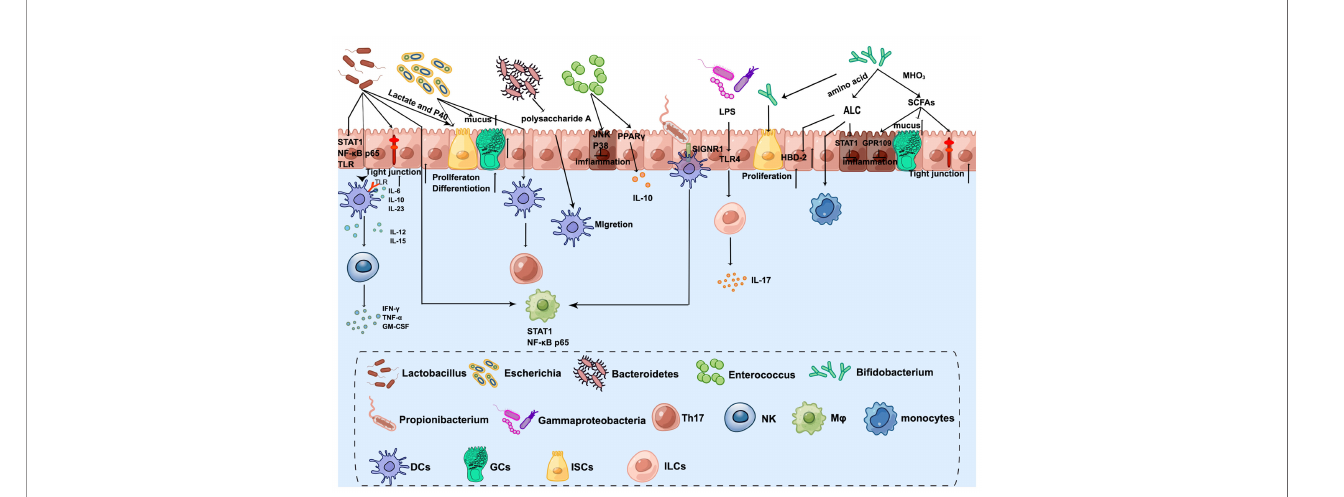
FIGURE 2 | The crosstalk between microbiota and innate immune system in the neonatal intestine. Lactobacillus enhances DC differentiation and upregulates surface markers, which activates NK cells. Furthermore, STAT1 and NF-kB p65 nuclear translocation are in fl uenced by Lactobacillus in both intestinal epithelial cells and underlying macrophages. Lactobacillus produced lactate and P40 can promote ISC-mediated epithelial development and tight junction formation. Bi fi dobacterium transfers amino acids into ALC, which activates monocytes and promotes the expression of beta-defensin2 of IECs. Additionally, ILA has anti-in fl ammatory effects on immature enterocytes through STAT1 pathways. Bi fi dobacterium releases SCFAs by metabolizing HMOs, which exert anti-in fl ammatory effects through GPR109A and increase tight junction and mucus gene expression. Furthermore, Bi fi dobacterium Tad pili stimulate the growth of the newborn mucosa. Escherichia increases the number of GCs and promotes mucus. The antigens of E. coli can be taken up by DCs and then present to CD4 + T cells to induce Th17. Bacteroides -produced Polysaccharide A mediates the migration of pDCs from the colon to the thymus to maintain PLZF + lymphocyte homeostasis. Enterococcus attenuates proin fl ammatory cytokine secretions, especially IL-8 through JNK and p38 signaling pathways. Furthermore, Enterococcus promotes PPAR phosphorylation activity to activate the transcription of IL-10. Propionibacterium combines with SIGNR1 on the DCs to regulate macrophages. Gammaproteobacteria express cell-surface LPS, which is recognized by the host intestinal cells via TLR4 and then ILC3 produces the cytokine IL-17A. By Figdraw (www. fi